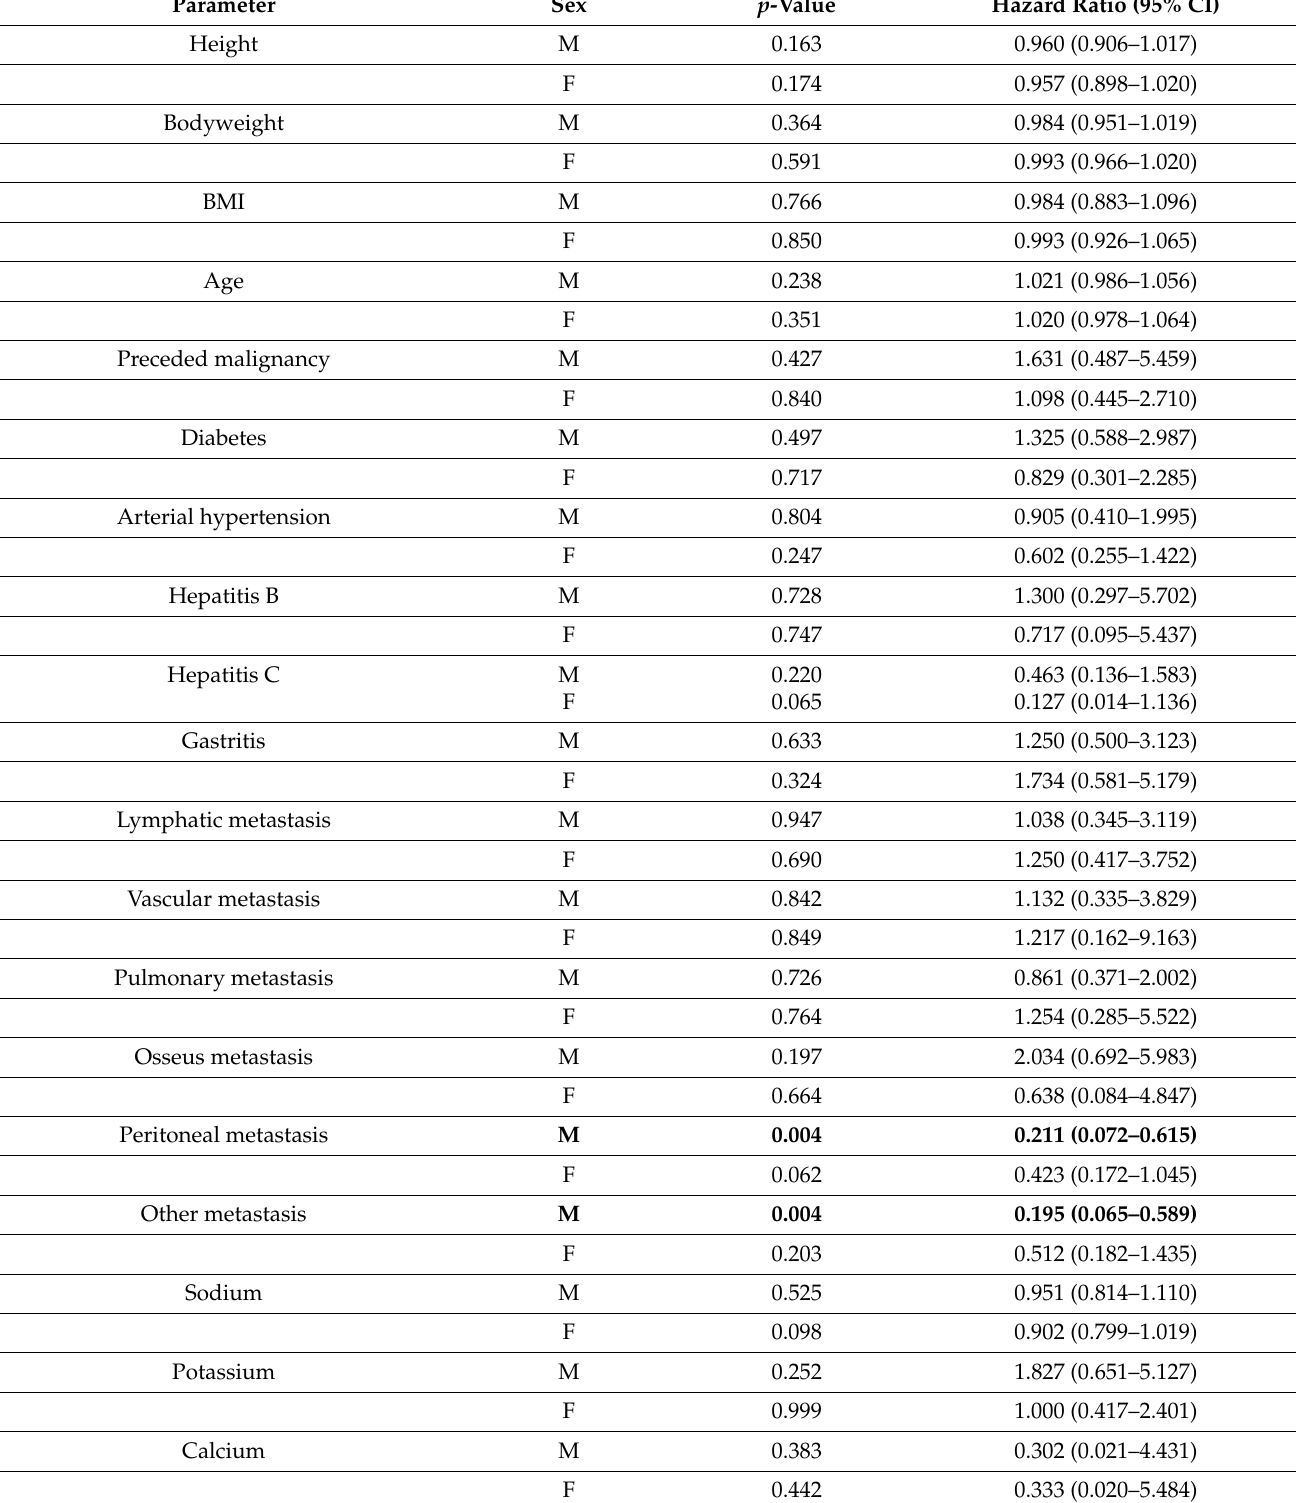
Table 4. Univariate Cox regression analysis for the prediction of sex-specific overall